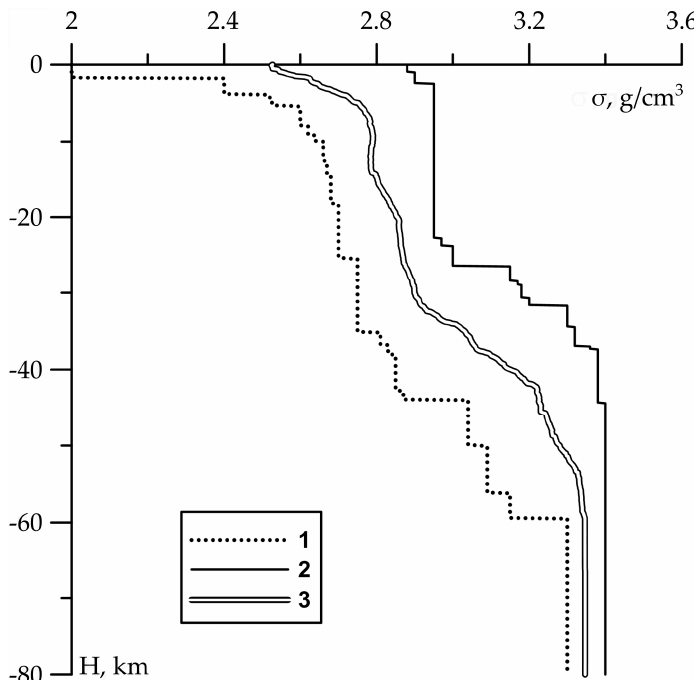
Figure 11. Initial ( a ) and fitted ( b ) 3D density model for the Timan-Pechora plate. The bottom image cuts along the shown Quartz profile.